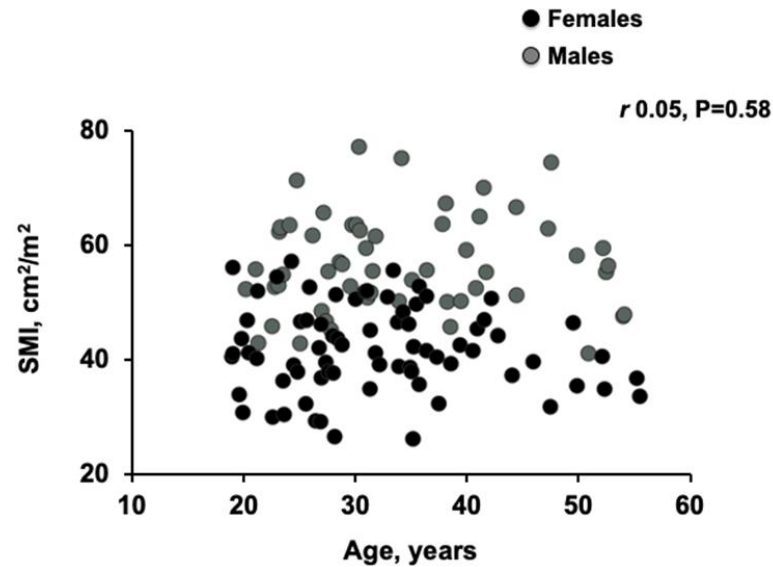
Figure 3. Scatter graph depicting correlations between skeletal muscle index (SMI) and age in donors. There was not any significant linear correlation (Pearson’s correlation) between SMI and age in donors ( r = 0.05, p = 0.58). Table 2. Sex-specific cut-off values of the skeletal muscle index (cm 2 /m 2 ) for sarcopenia in cirrhosis. Skeletal muscle index two SD below the mean of a young healthy donor Skeletal muscle index one SD below the mean of a young healthy donor